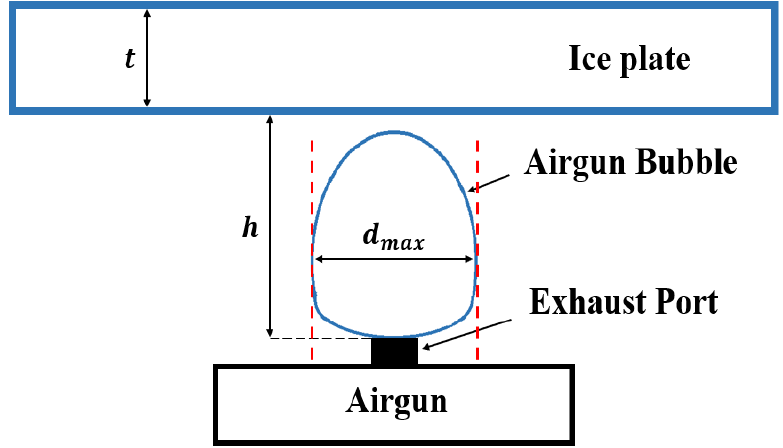
Figure 5. Schematic of dimensionless parameters.